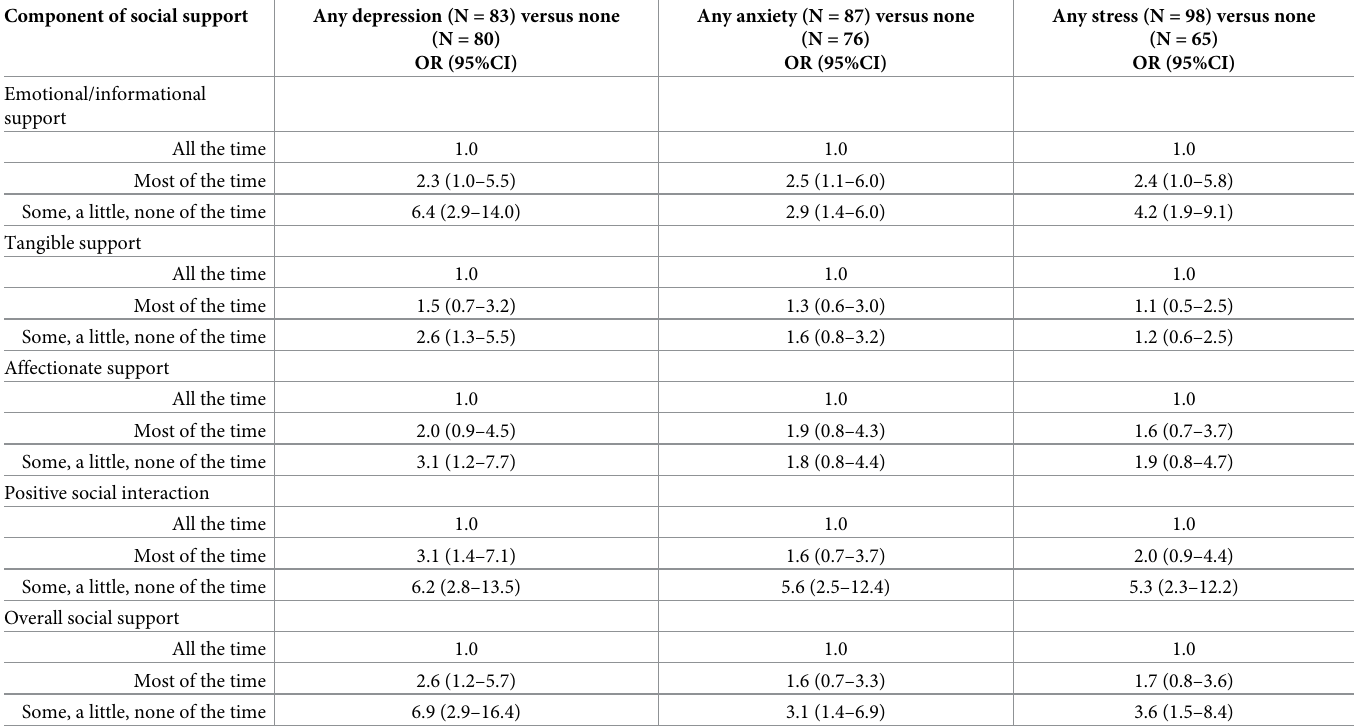
Table 4. Association of social support with depression, anxiety and stress among mothers of child with CZS. Component of social